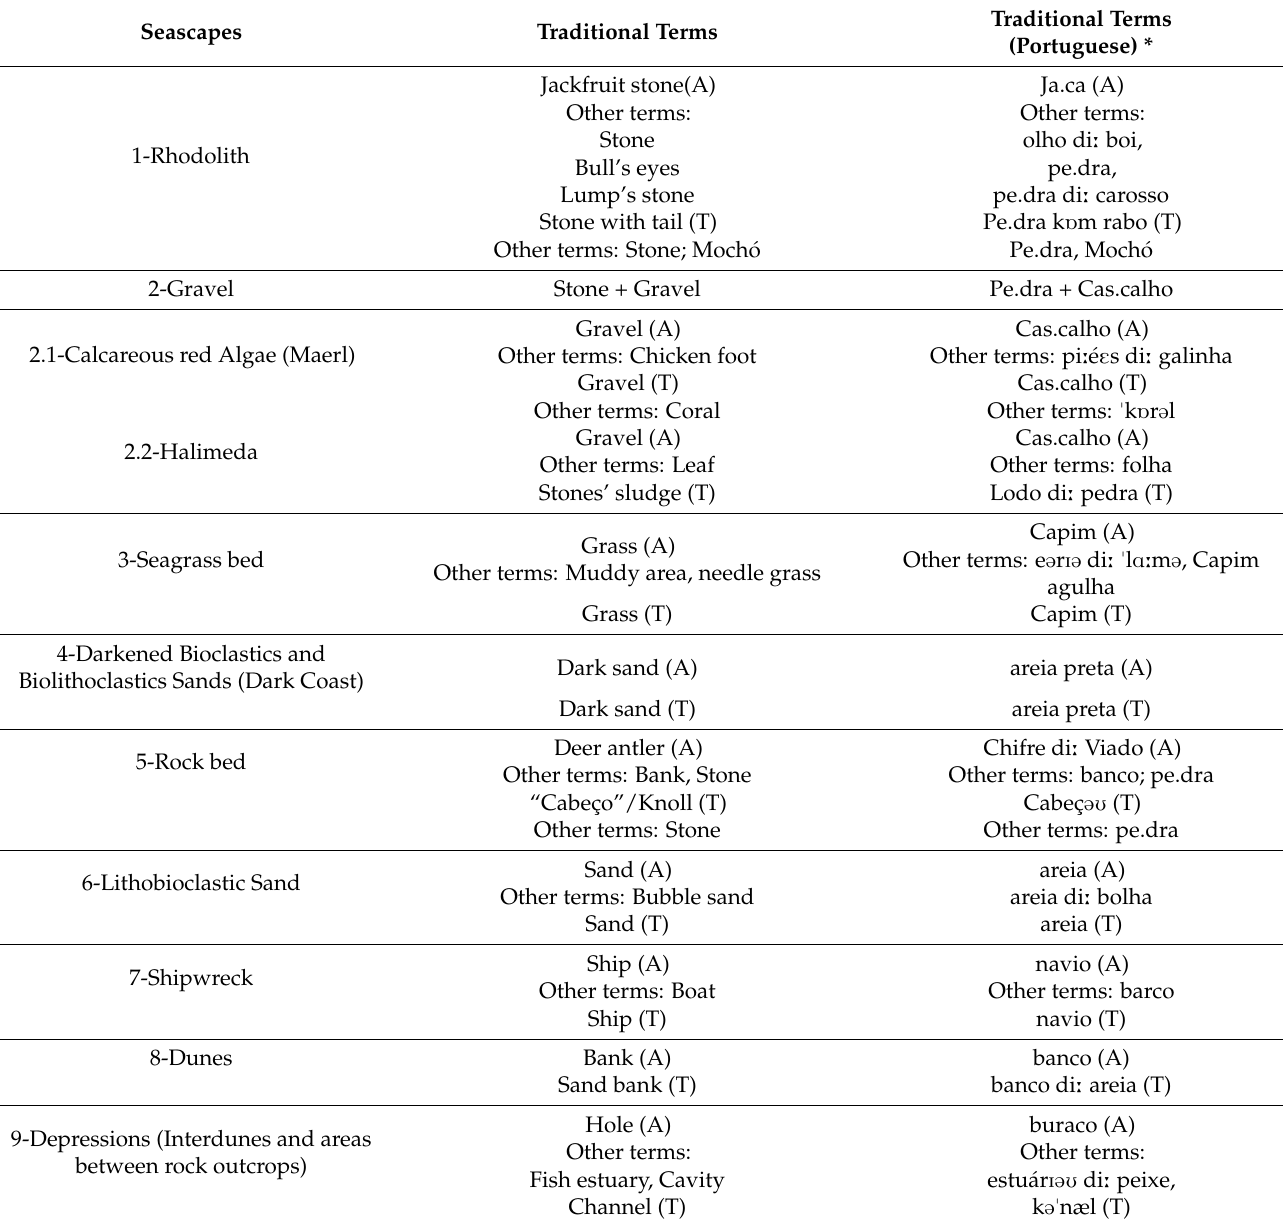
Table 1. Traditional terms used for seascapes by the fishermen of Almofala (A) and Tapera (T).